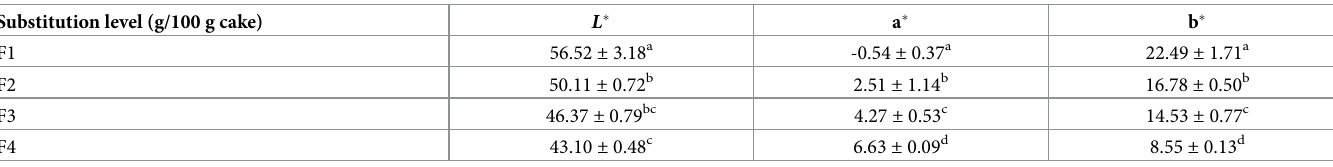
Each value in the table is represented as mean ± SD ( n = 5). a,b,c,d Values with same superscript letters in the same row are non-significant at p < 0.05. L � , a � and b � represent bright, red and yellow indexes,